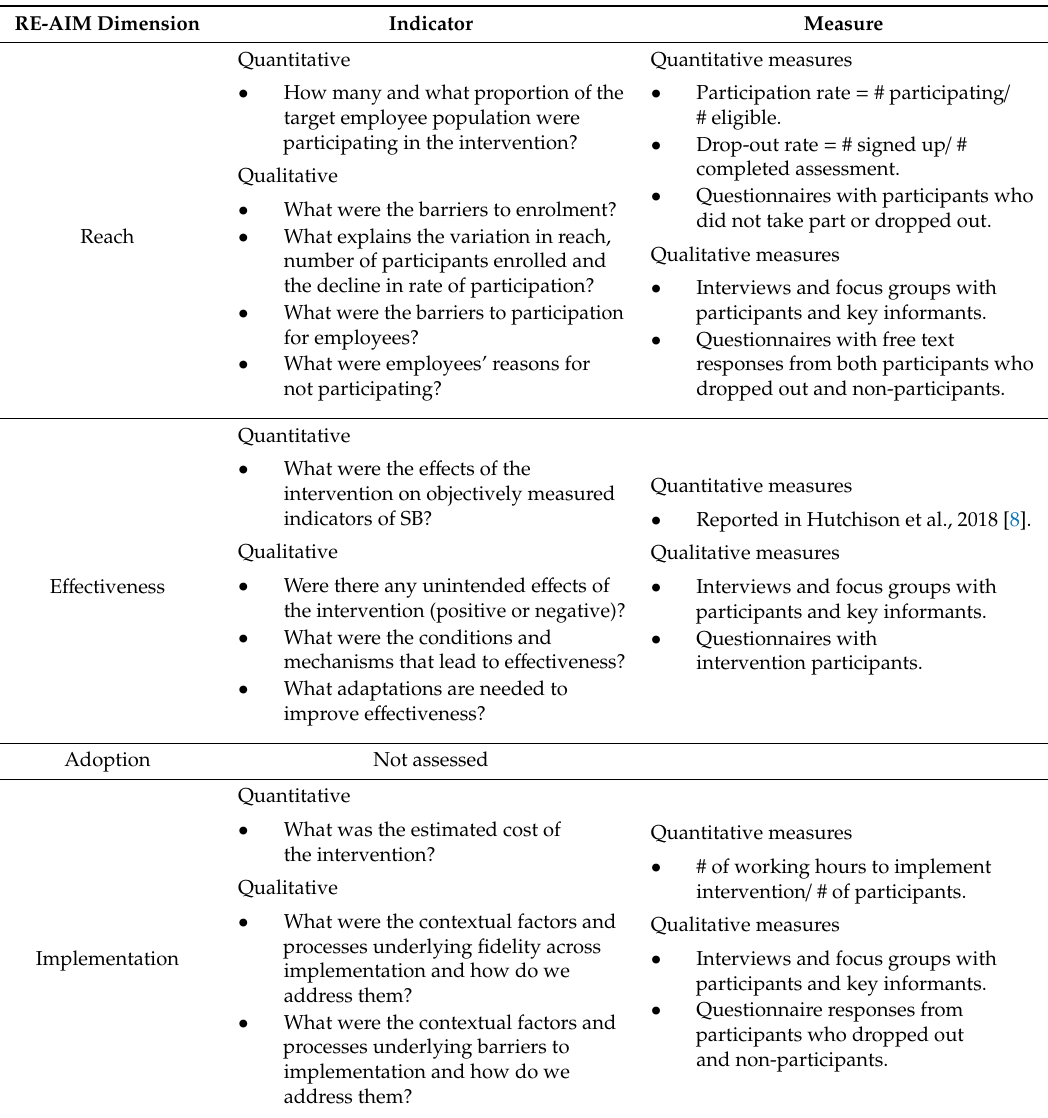
Table 3. RE-AIM dimensions, indicators assessed and the data source used to measure or inform